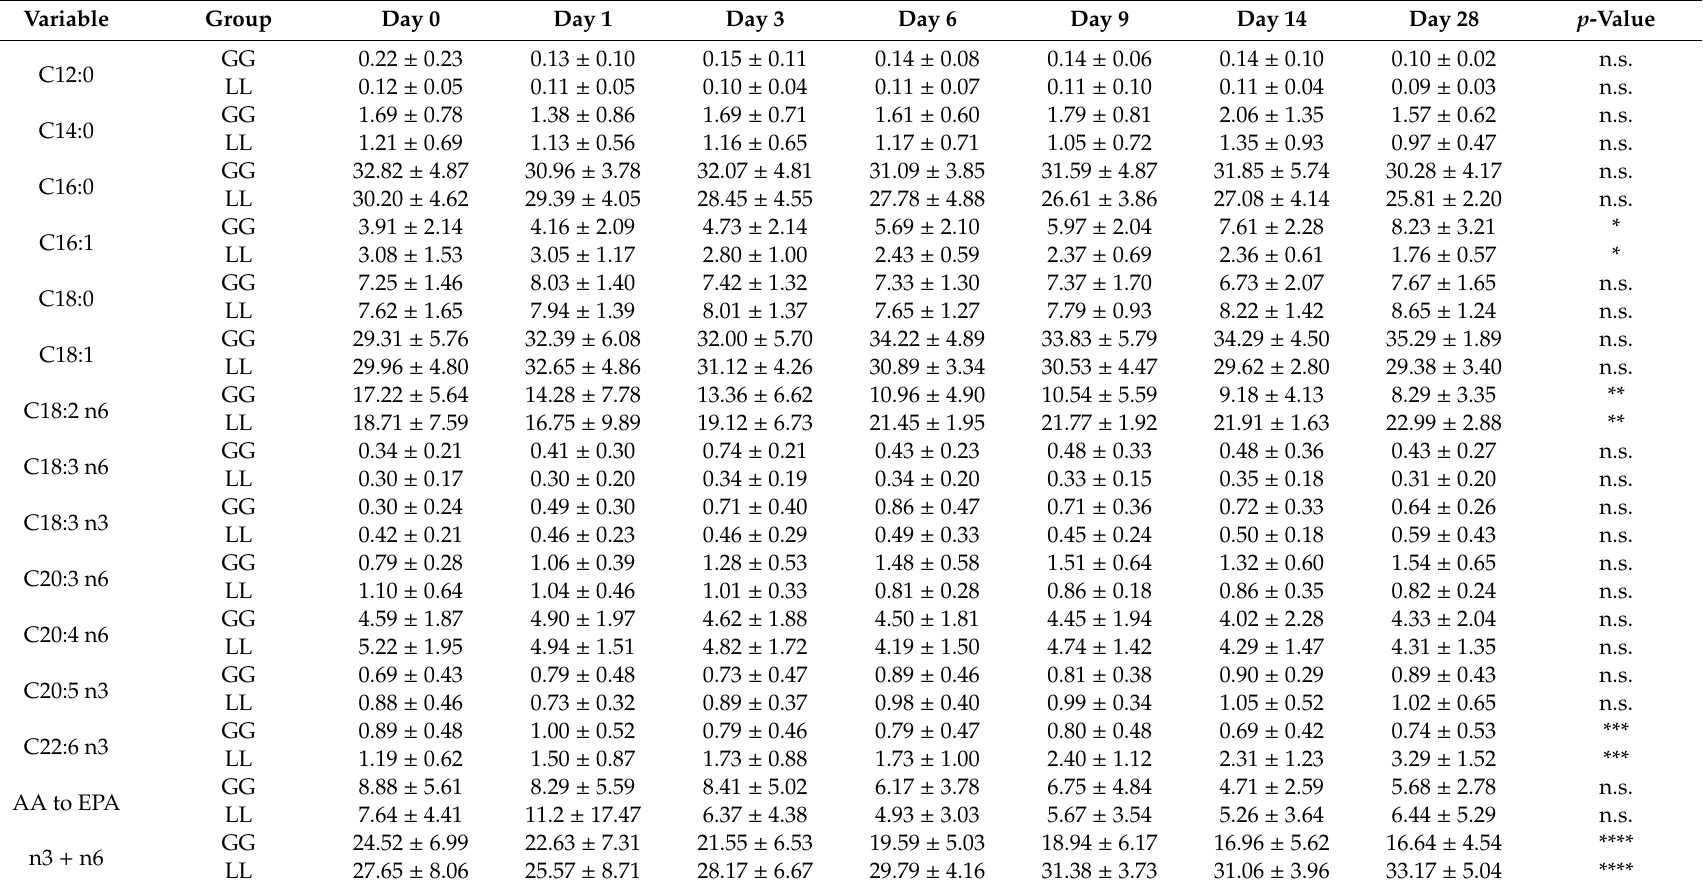
Table 4. Individual fatty acids (weight percentage of total fatty acids,